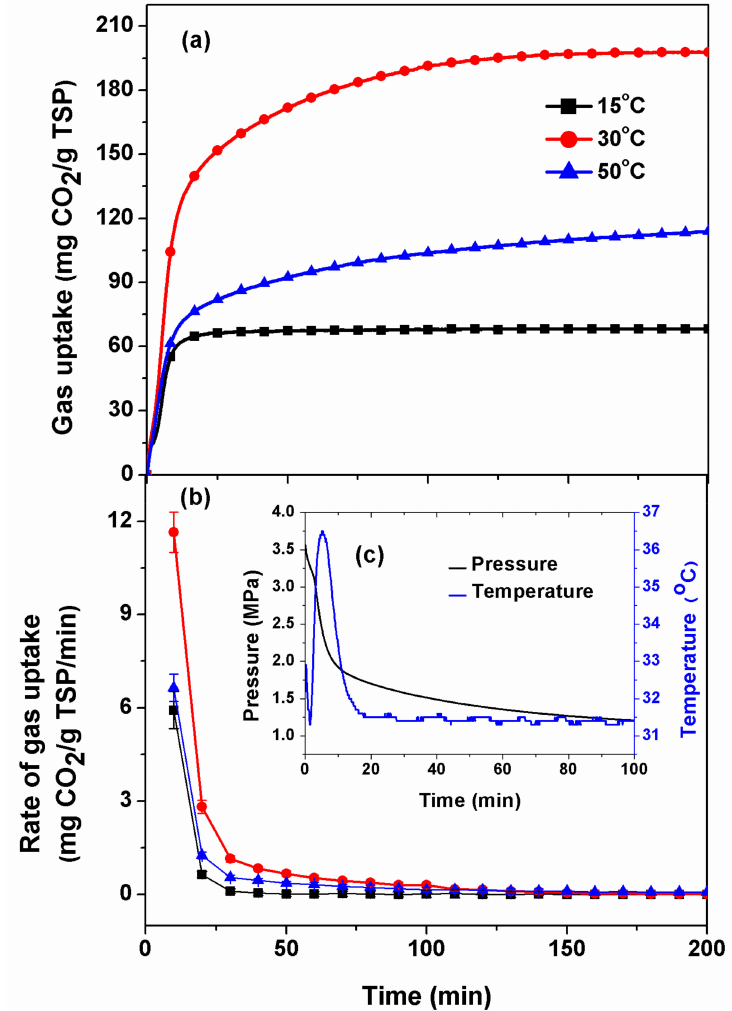
Figure 4. ( a ) Comparison of CO 2 uptake capacity (mg of CO 2 / g of sorbent) at 3.5 MPa pressure and three di ff erent temperatures (15, 30, and 50 ◦ C); ( b ) Rate of gas uptake (mg of CO 2 / g of sorbent / min) for the same system; ( c ) pressure and temperature data with respect to time at 30 ◦ C (Curves provided to guide the